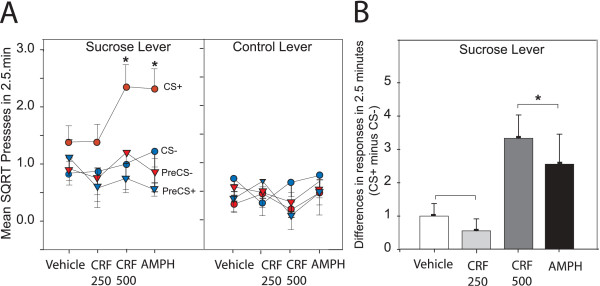
Enhancement of incentive motivation by CRF. Effects on cue-triggered lever pressing during extinction test caused by CRF (250 and 500 ng) and amphetamine (20 μg) microinjections in the caudal medial accumbens shell. A. Lines show pressing in the presence of the CS+ (previously associated with sucrose- red circles); and CS- (never associated with sucrose- blue circles); and pre-CS+ baseline period (no-stimulus 30 sec period immediately prior to CS+ stimulus); and pre-CS- baseline period (30 sec immediately prior to CS- stimulus). The left panel depicts lever pressing on the control lever that had previously produced instrumental sucrose reward during training (but not during extinction test). The right panel depicts lever pressing on the control lever that was never had produced reward. Both 500 ng CRF and 20 μg amphetamine increased the ability of the sucrose CS+ cue (but not CS-) to trigger enhanced responding on the previously sucrose-associated lever (but not on the control lever). B. Transform scores show a direct contrast between CS+ and CS- effects of lever pressing. CS+ effects on cue-triggered lever pressing are amplified by CRF (500 ng) and by amphetamine (20 μg) microinjections.